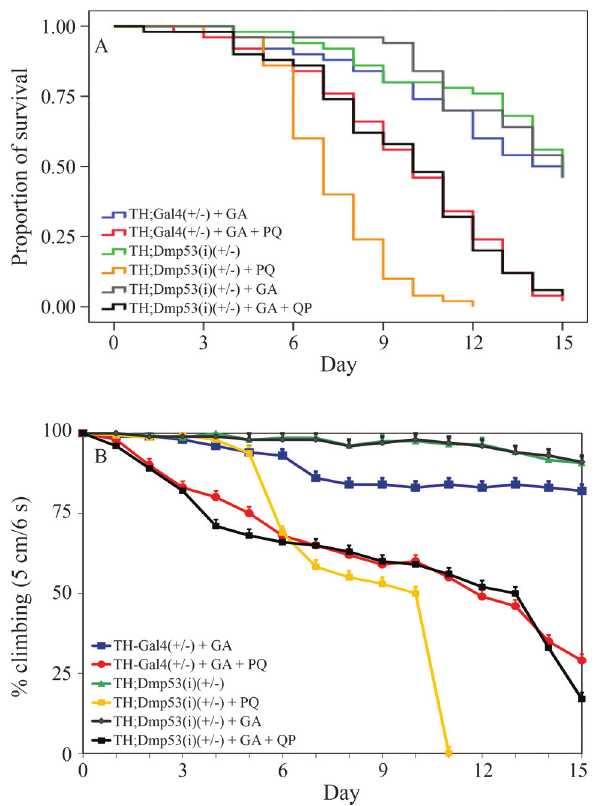
Figure 5 - Gallic acid (GA) increases survival (A) and locomotor activity (B) in gene knockdown Drosophila melanogaster lines exposed to paraquat. Female flies (n = 50 per treatment) were treated as described in Materials and Methods . The graphs show that the proportion of survival (A) and climbing performance (B) were significantly increased in TH-Gal4 +/- ,UAS-Dmp53 RNAi +/- flies treated with (1 mM) PQ and (0.1 mM) GA. Similar results were obtained with TH-Gal4 +/- , UAS-bsk RNAi +/- and TH-Gal4 +/- , UAS-drICE RNAi +/- flies (Table 1). Statistical comparisonsbetweenuntreatedandtreatedfliesshowed:(A)ap<0.05by log-rank test and (B) a p < 0.05 by (cid:2) 2 test. Comparisons between gene